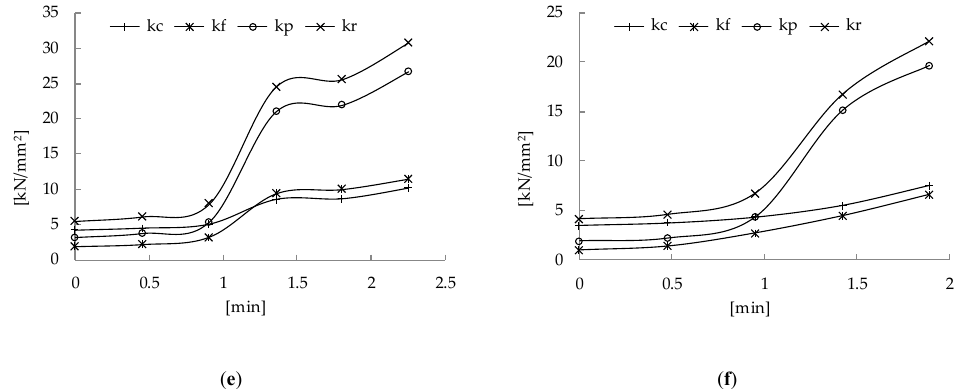
ff erent cutting conditions